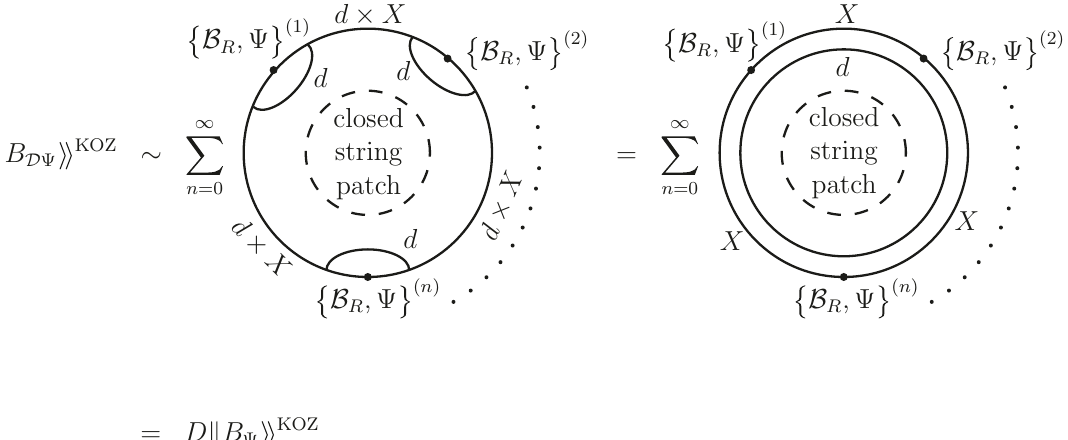
Figure 20 . Pictorial representation of the KOZ boundary state for a defect-acted solution (the boundary integrals in the “Pexp” operation, as well as other details, are not shown, as they are not important for our argument). Thanks to the defect distributivity, the various open string defects result in a single defect-loop encircling the closed string coordinate